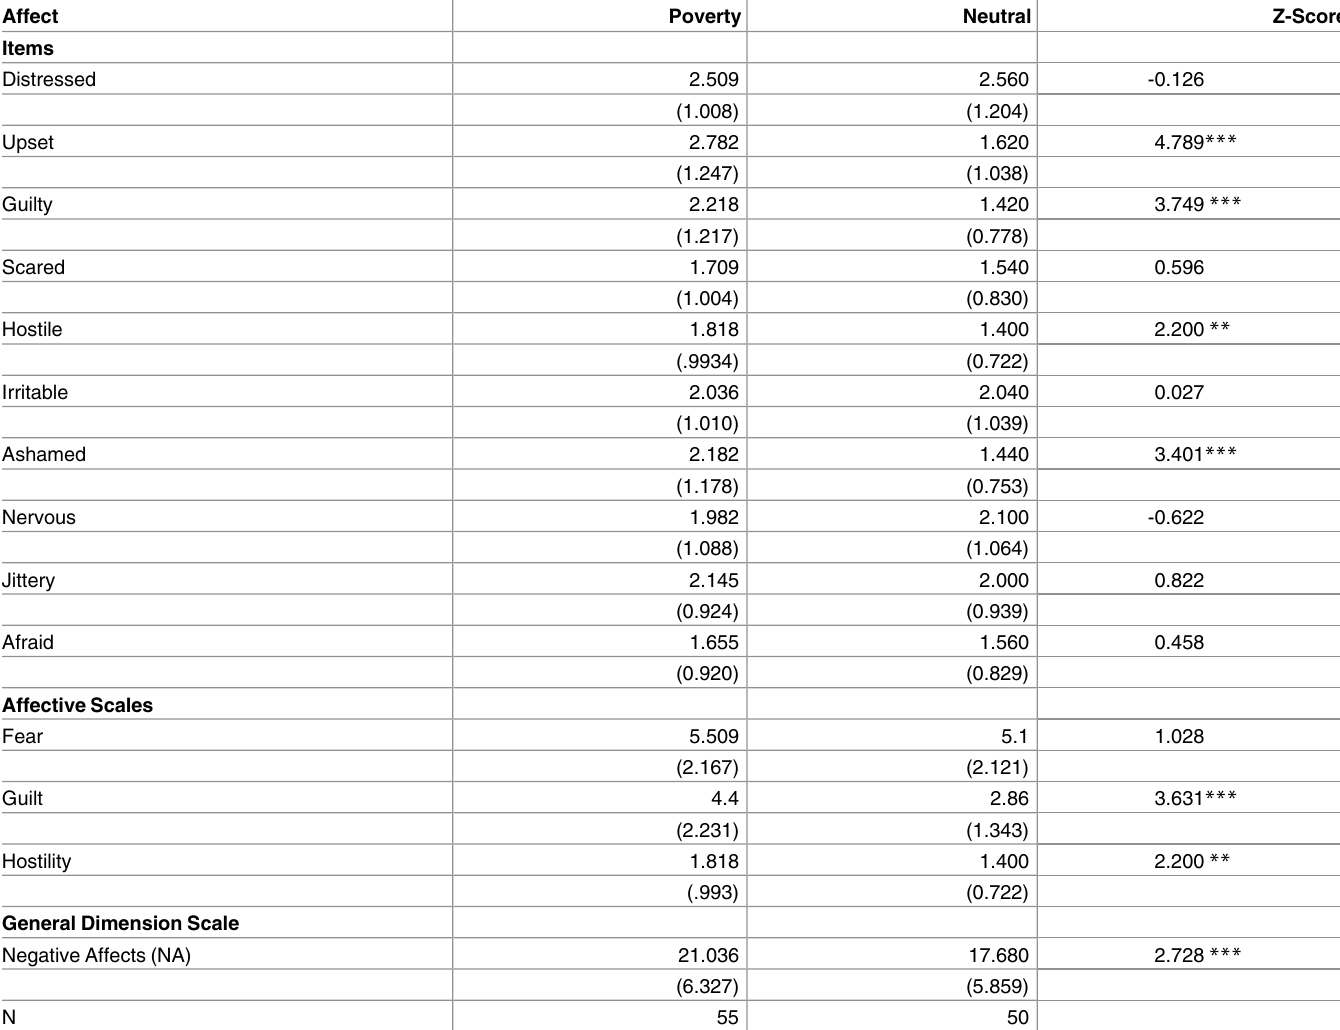
Table 3. Averageand Standard Deviation of Negative Affect Scales, by